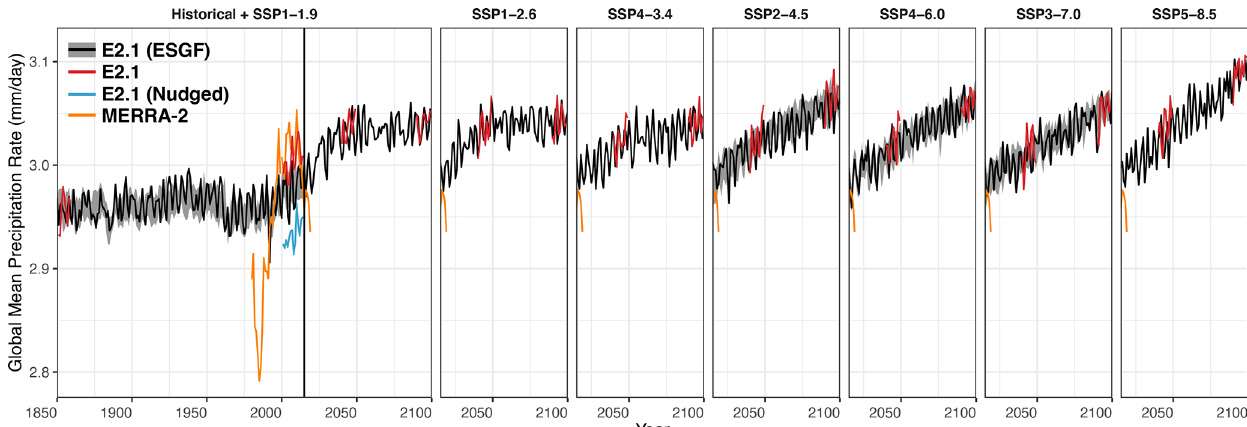
Figure 3. The same as Fig. 2 but showing the temporal evolution of the global mean precipitation rate in mmd − 1 (variable pr on ESGF).